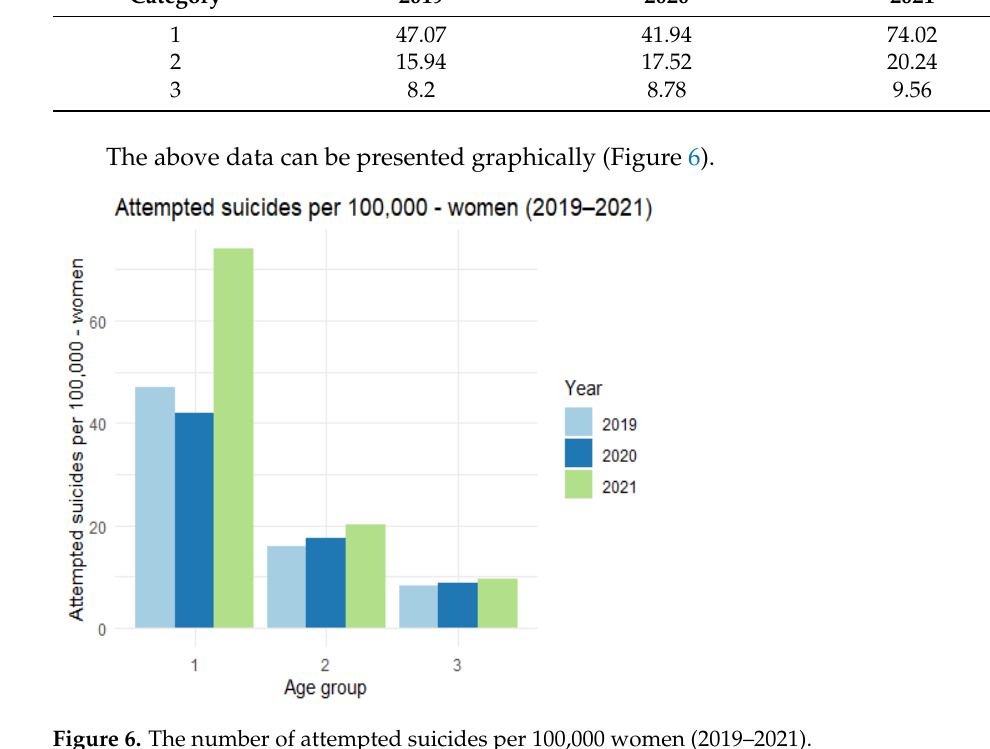
Table 4. The number of attempted suicides per 100,000 men (2019–2021).